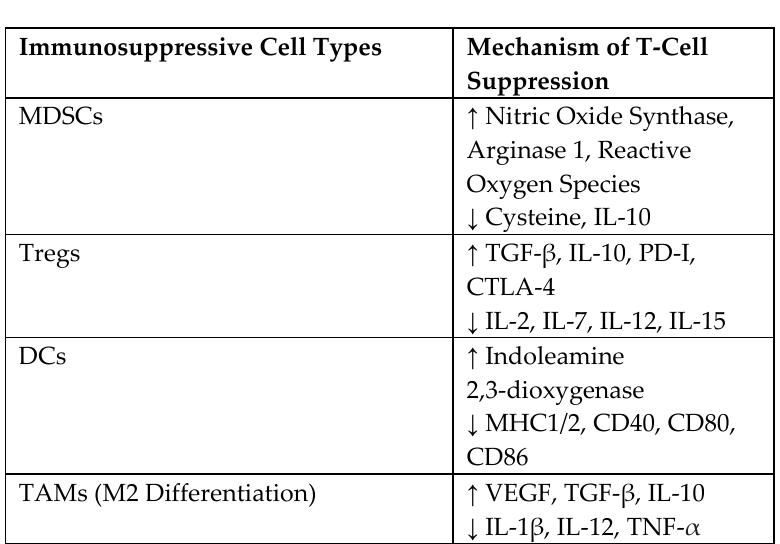
Figure 2. Cellular mediators of immune suppression in the tumor microenvironment. ( A ) Dysregulated immune cells that contribute to tumor immune escape include myeloid-derived suppressor cells (MDSCs), regulatory T-cells (Tregs), dendritic cells (DCs) and tumor-associated macrophages (TAMs). ( B ) Experimentally observed mechanisms of T-cell suppression by these cells are described, with multiple molecular mediators of immune suppression depicted. In addition, the cells have impaired tumorocidal activity and defective normal properties.